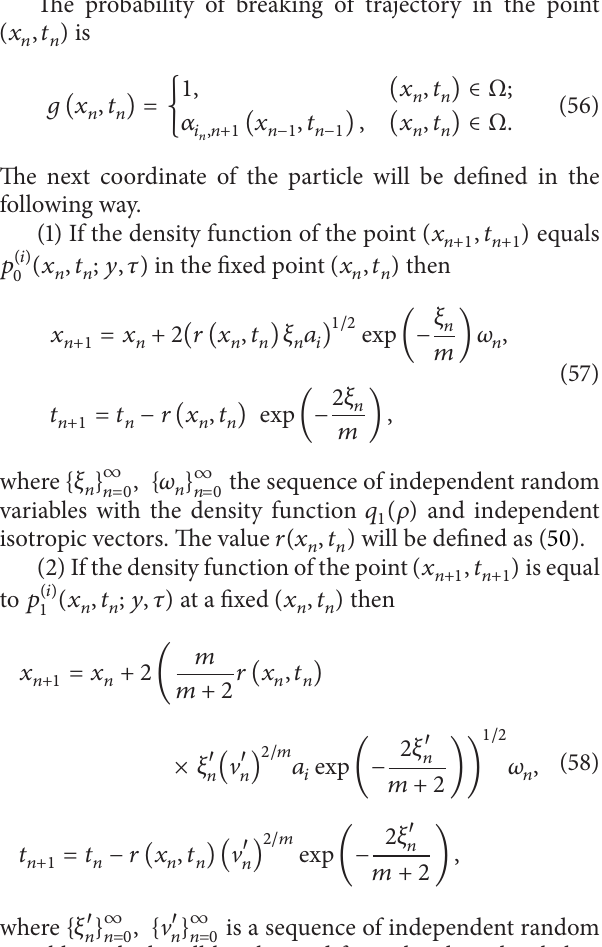
(Algorithm 4) (Neumann acceptance rejection method). Algorithm 4. (a) We firstly simulate 𝜉 , Gamma distributed random variable with the parameters (𝑚/2) , secondly sim- ulate 𝛾 , uniformly distributed random variable on (0, 1),